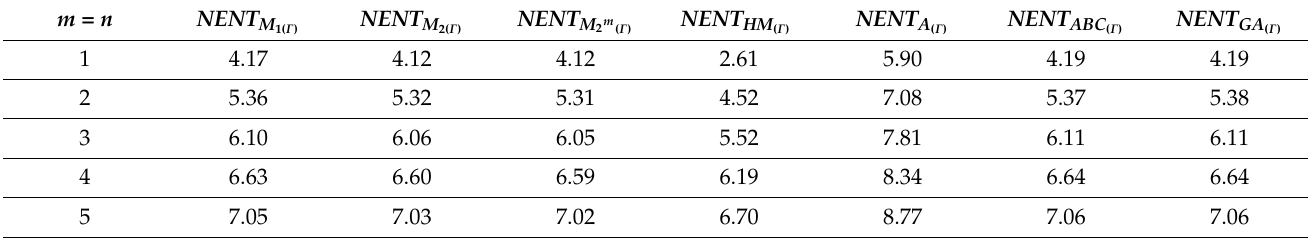
Table 10. Comparison Table for Theorem 6.